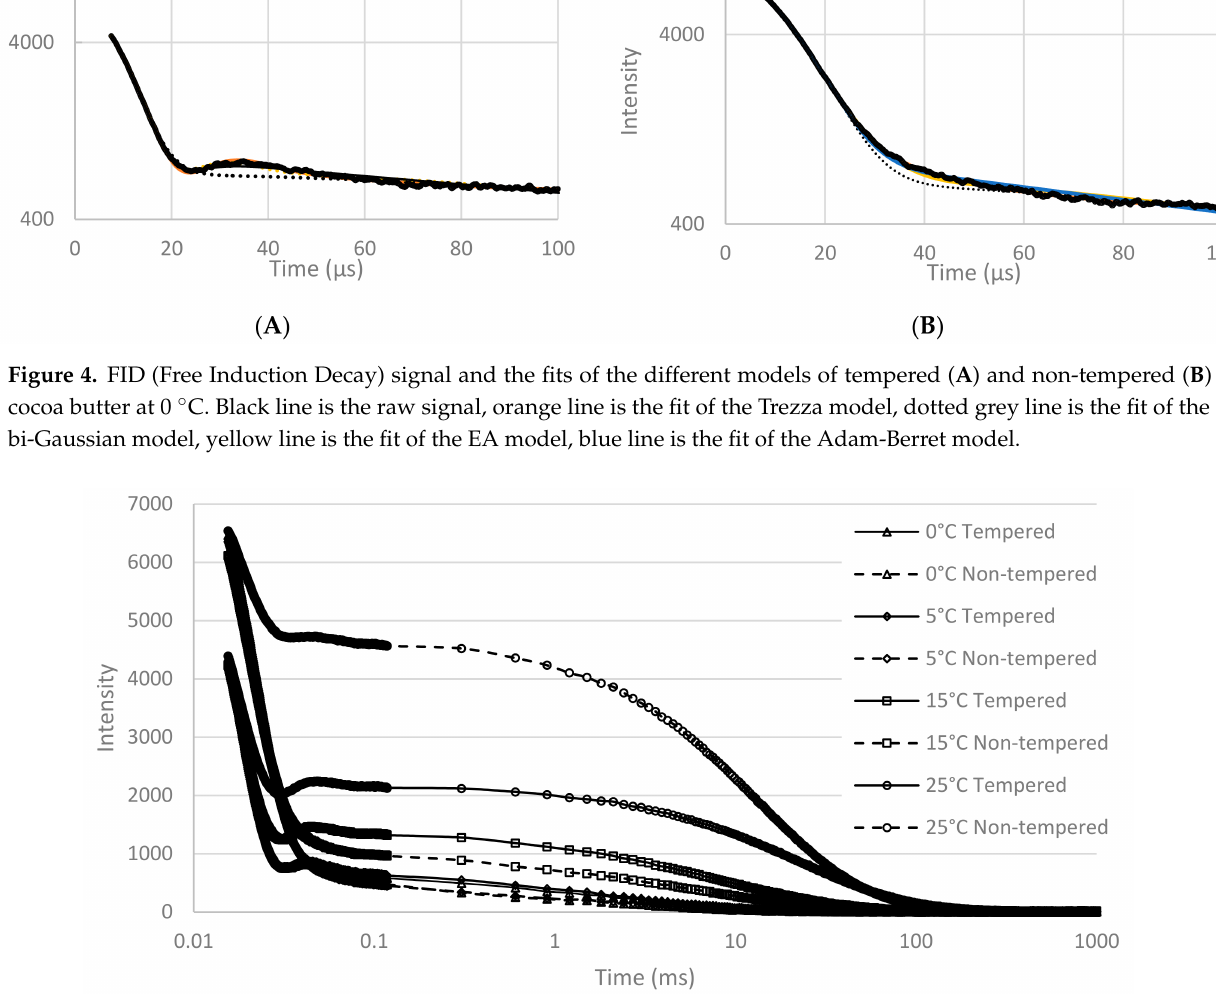
Figure 5. FID-CPMG signal of tempered (full lines) and non-tempered (broken lines) cocoa butter at 0 ◦ C (triangles), 5 ◦ C (diamonds), 15 ◦ C (squares), and 25 ◦ C